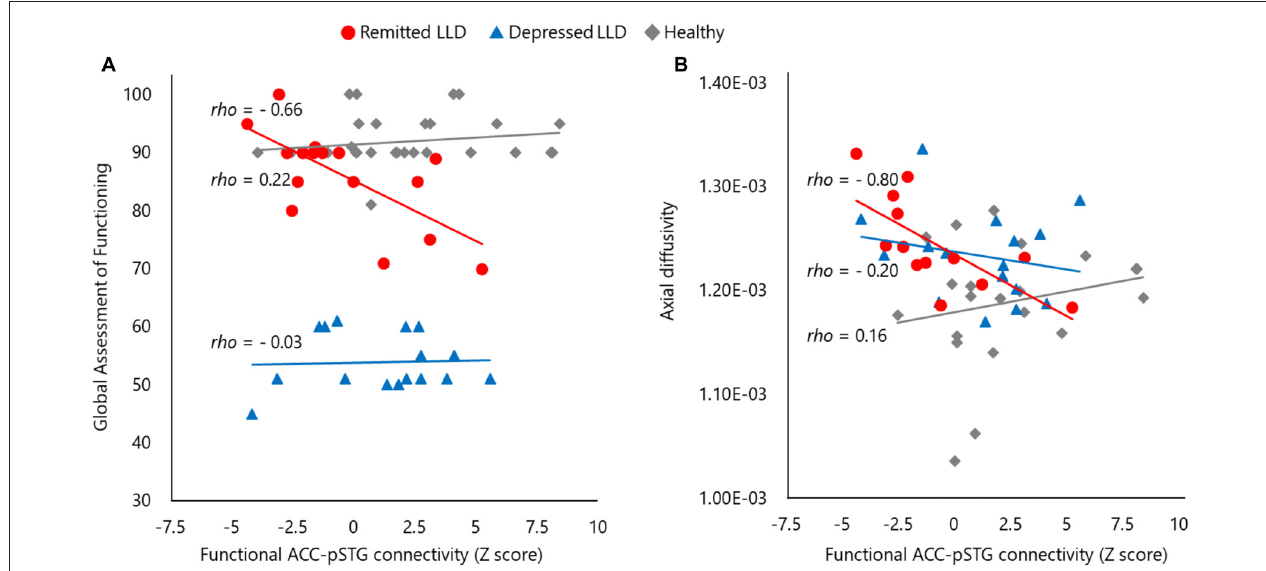
FIGURE 4 | The scatter plots of between functional and structural connectivity and the global functioning. Functional connectivity of anterior cingulate and posterior superior temporal gyrus pSTG (ACC–pSTG) showed a significantly inverse correlation in the score of global assessment of functioning (A) and structural ACC–pSTG connectivity (B) in patients with LLD in the remitted phase (red circle), but not in patients with LLD in the depresses phase (blue triangle) or healthy participants (gray diamond).